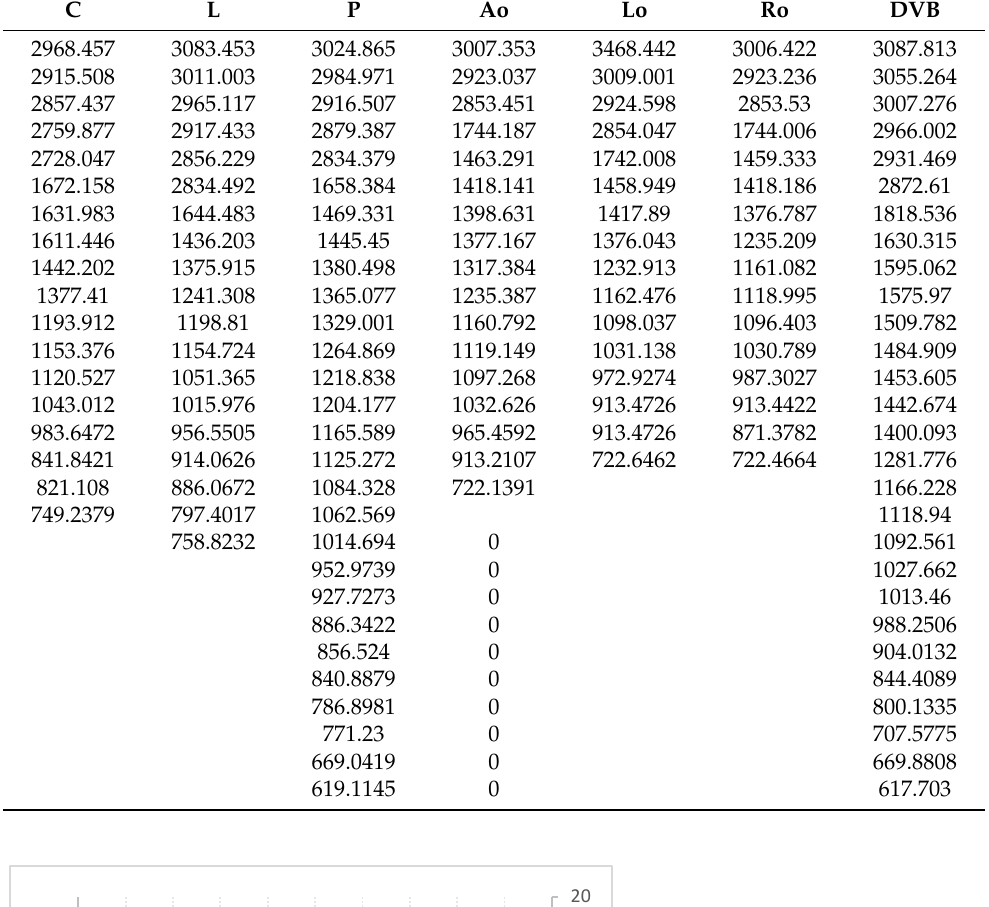
Table A1. Wave numbers of monomers.